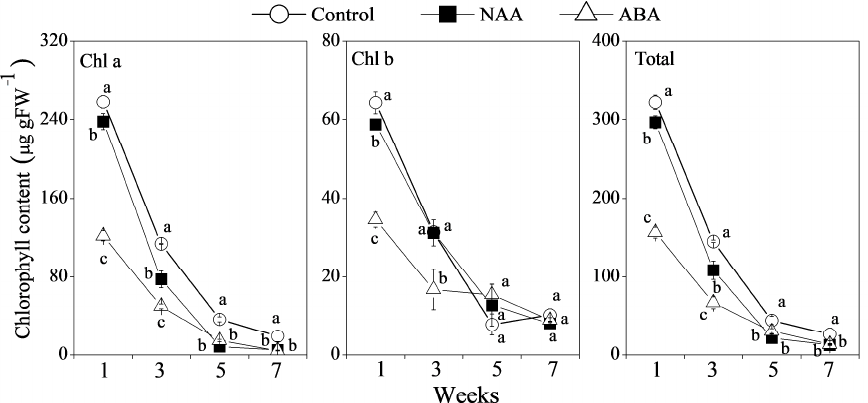
Figure 4. Effect of NAA and ABA on chlorophyll content in the flavedo of GA and PDJ-treated citrus fruit. Chl a, chlorophyll a; Chl b, chlorophyll b; Total, total chlorophyll. The results shown are the mean ± SE for triplicate samples. Different letters (a, b, and c) indicate significant differences at the 5% level by Tukey’s test.